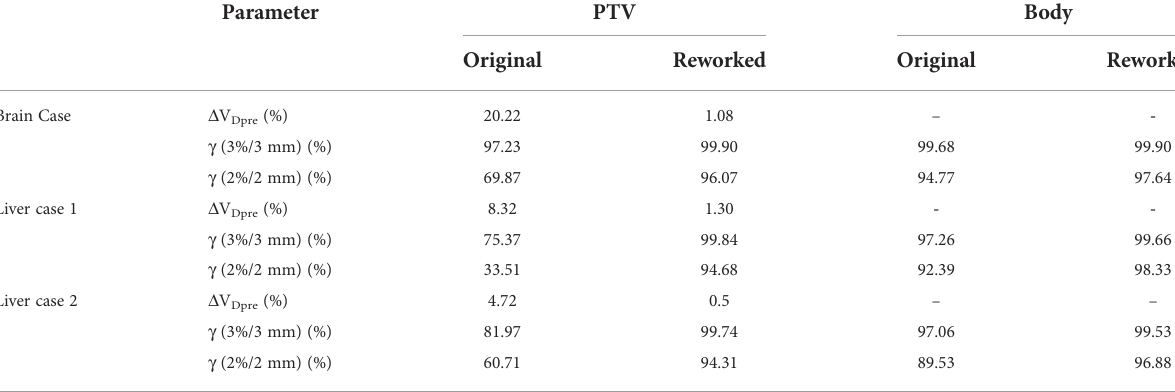
TABLE 7 Absolute difference of target DVH dosimetric parameters between CT and syCT, before and after plan